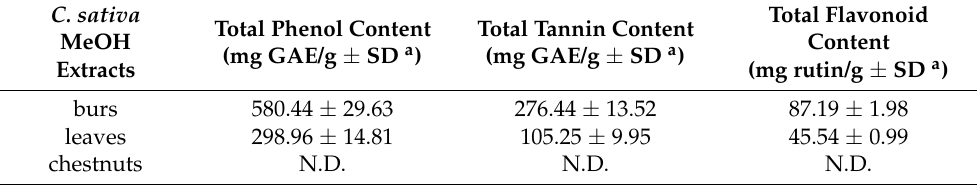
Table 1. Total phenol, total tannin and total flavonoid content of MeOH extracts of C. sativa (Marrone di Roccadaspide) burs, leaves, and chestnuts.